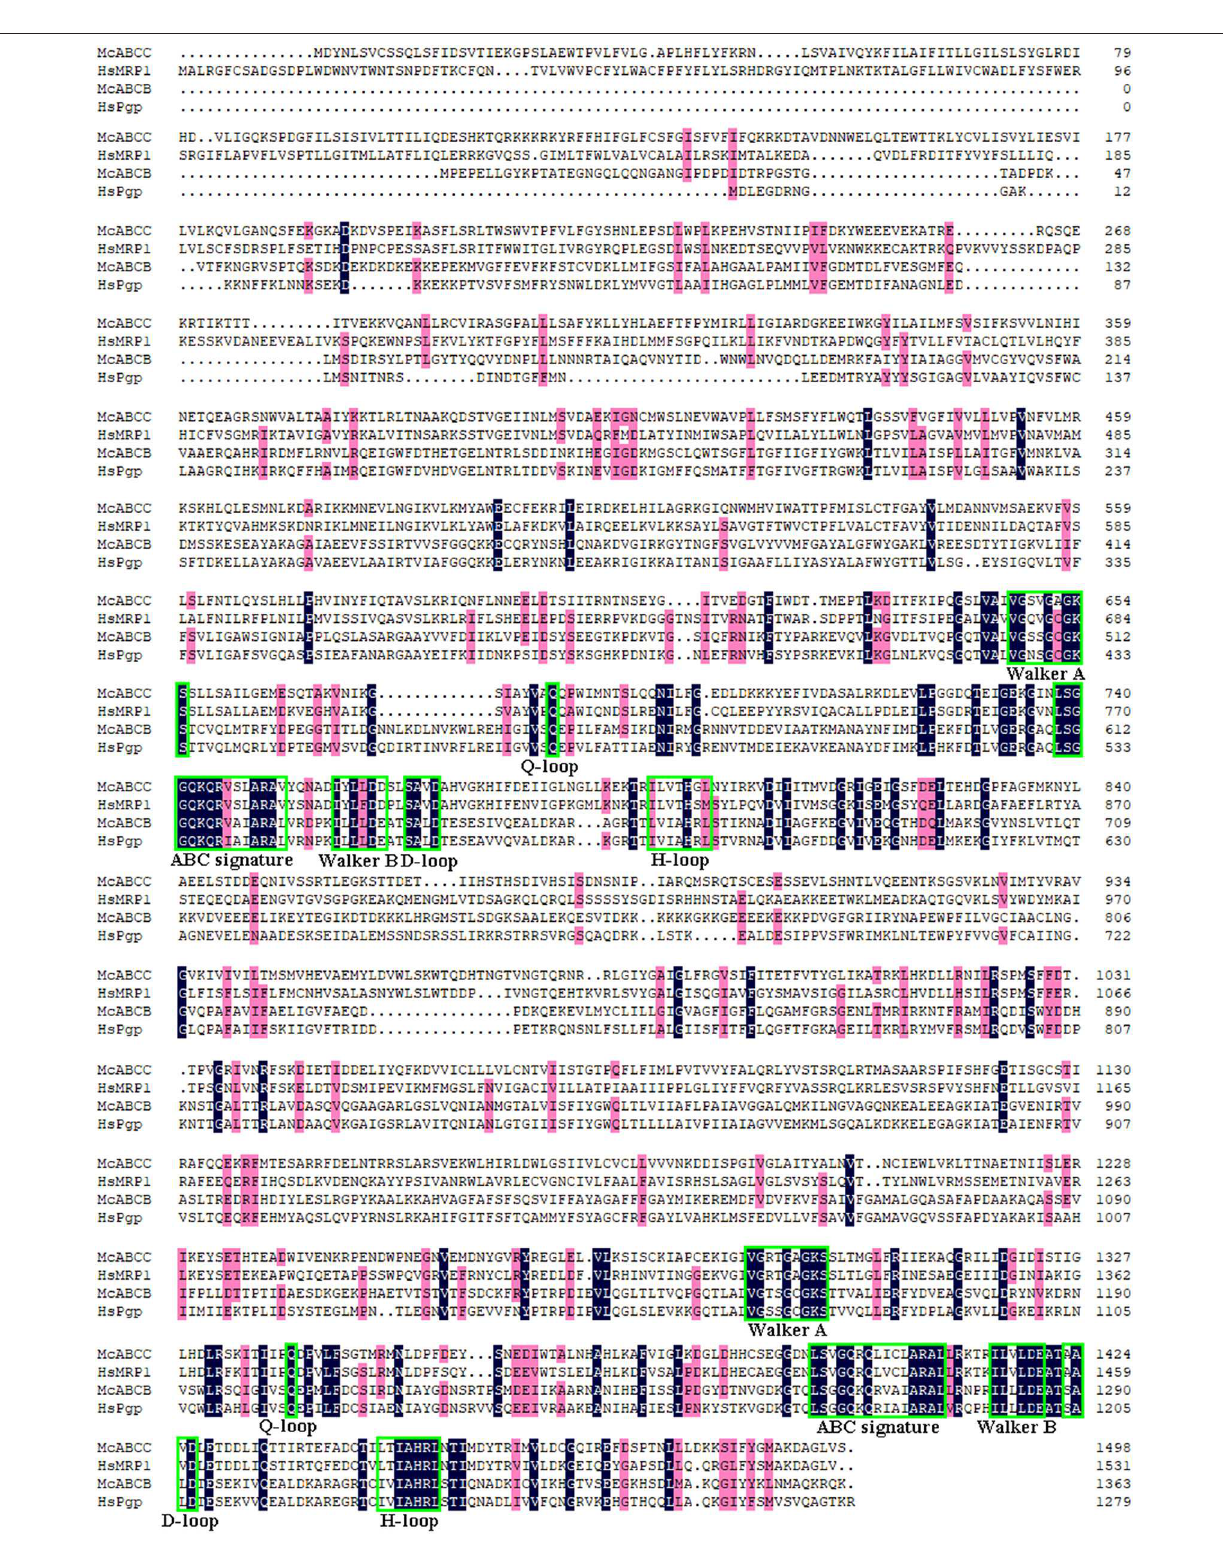
Frontiers in Marine Science | www.frontiersin.org